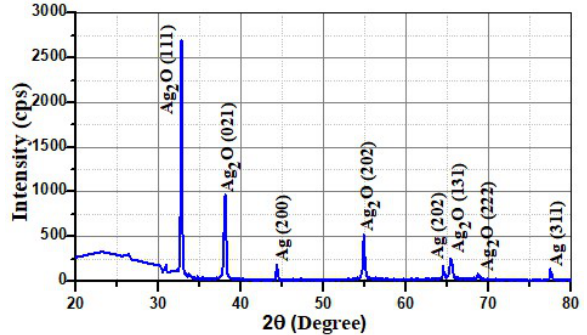
Figure 1: Grazing incident XRD patterns of Ag 2 O